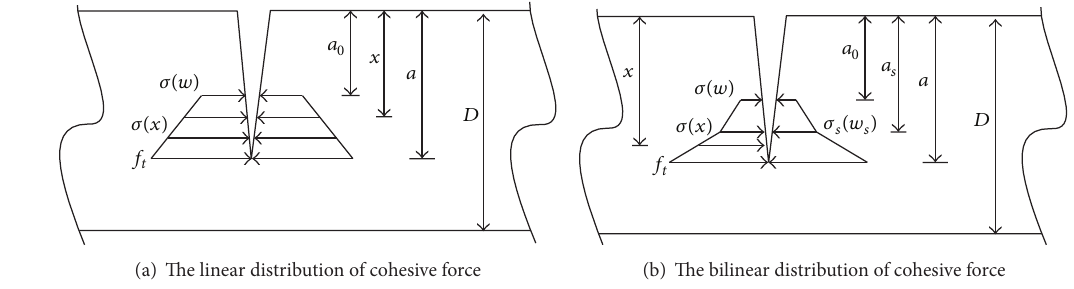
Figure 3: Two different situations for CTOD